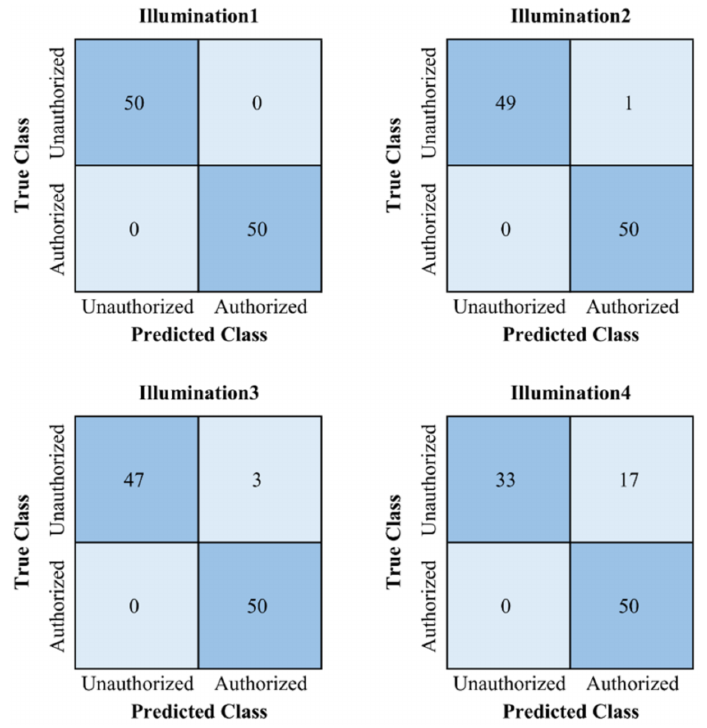
Figure 18. The confusion matrix of AlexNet under different